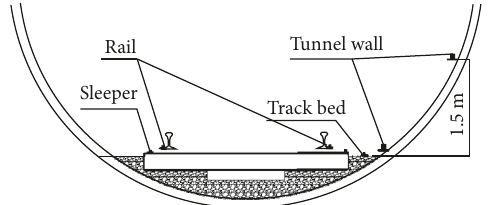
Figure 5: Arrangement of acceleration measuring points in the